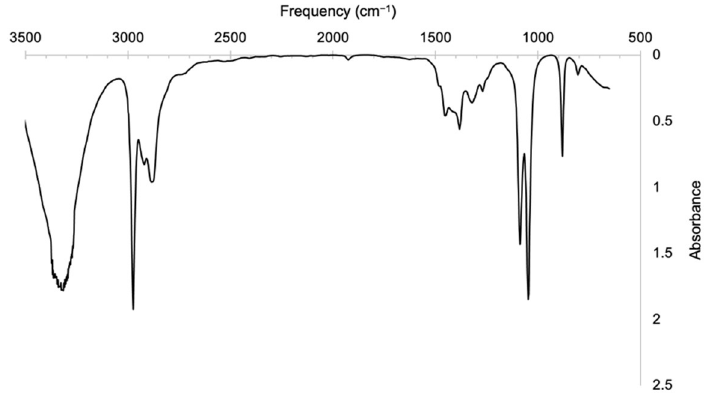
Figure 4. Experimental spectra of ethanol obtained from NIST database [25].